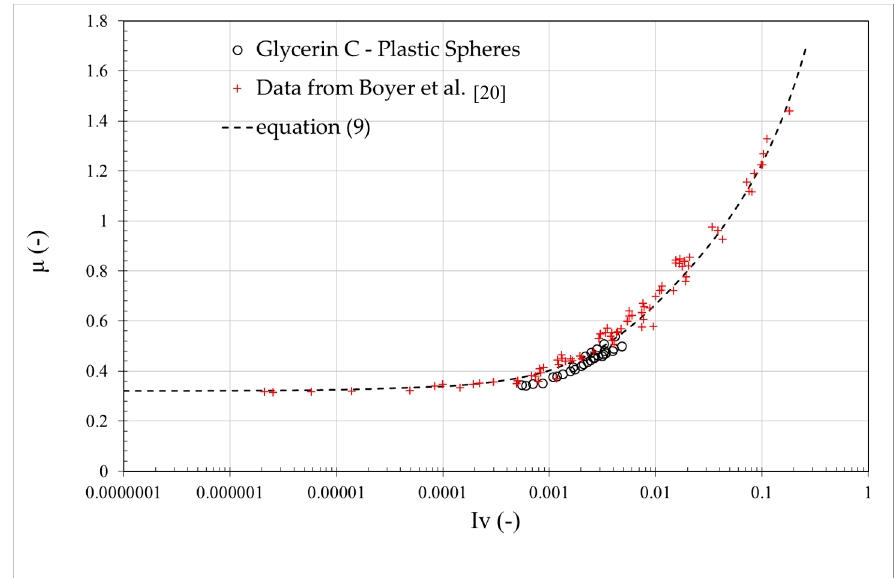
Figure 10. Plastic sphere–glycerin C solution: relationship between the friction coefficient µ and the viscous number I v compared with the data reported by Boyer et al. [20] for viscous suspensions, plotted in a semi logarithmic chart to appreciate the value of the static friction coefficient µ 1 . Dashed line: theoretical curve from Equation (9) with µ 1 = 0.32, µ 2 = 0.7, and I 0 = 0.05.